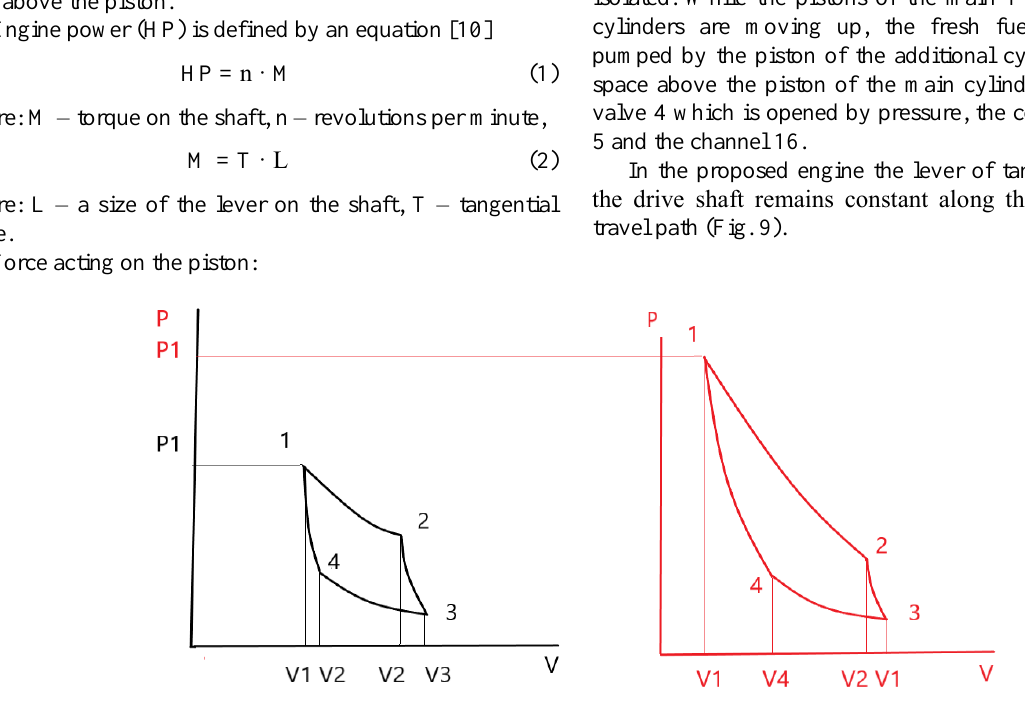
Fig. 8. Cycle: a) in the traditional engine, b) in the new